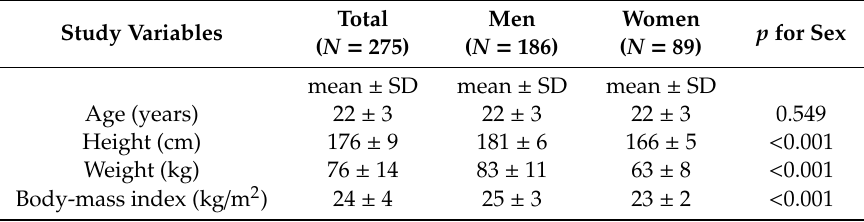
Table 1. Basic descriptive statistics of the study participants ( N =